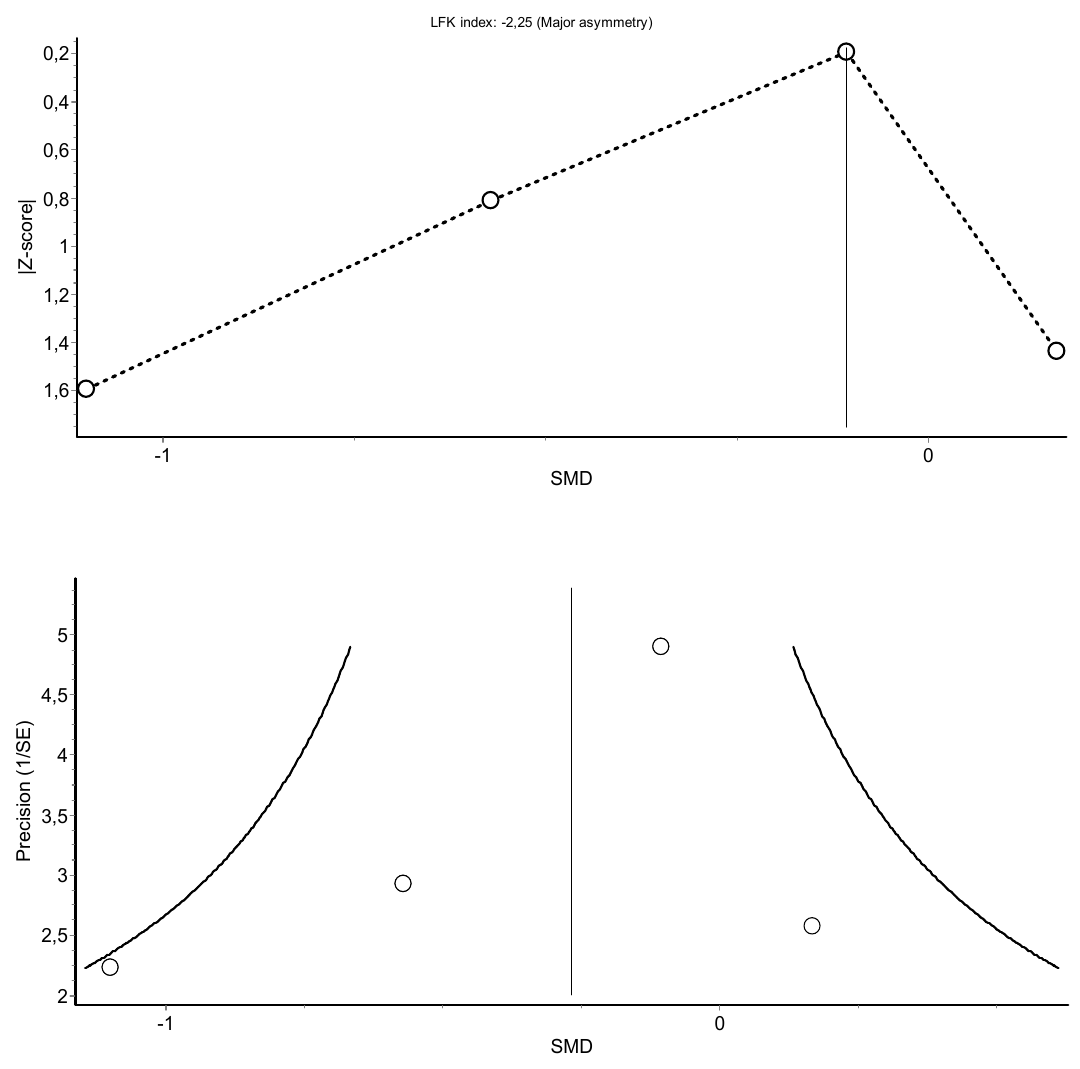
Figure A8. Synthesis forest plot of body fat variable. Negative favor HIIT intervention. The forest plot summarizes the results of included studies (standardized mean differences [SMDs] and